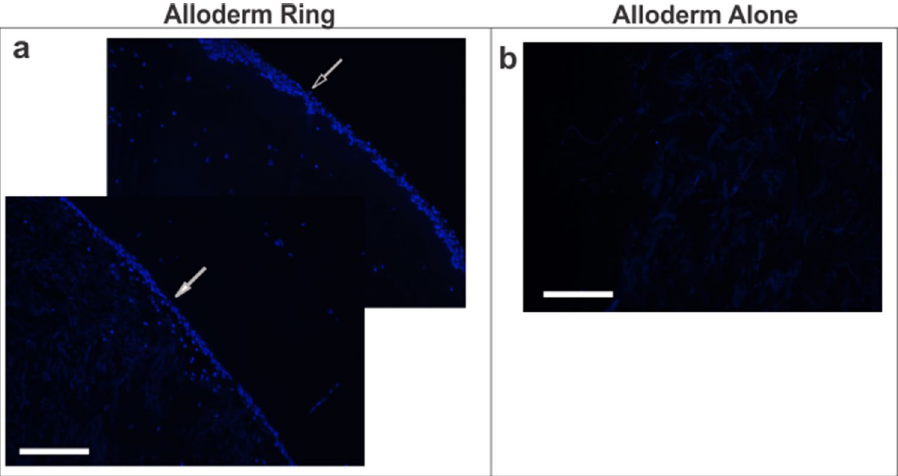
Figure 5. Cells infiltrated the Alloderm ECM in the engineered vascular tissue. DAPI stains of ( a ) an Alloderm-integrated vascular ring and ( b ) Alloderm alone. ( a ) Positive DAPI stain in Alloderm rings on the edge indicate cells seeded on the outer surface during the ring formation process (white open arrow), and positive DAPI stain in the Alloderm indicates cell infiltration (white closed arrow). ( b ) Lack of positive DAPI stain in the Alloderm alone verifies lack of cell presence prior to cell seeding, indicating that cells presence in the Alloderm in the rings ( a ) is due to cell infiltration. Scale bars = 200